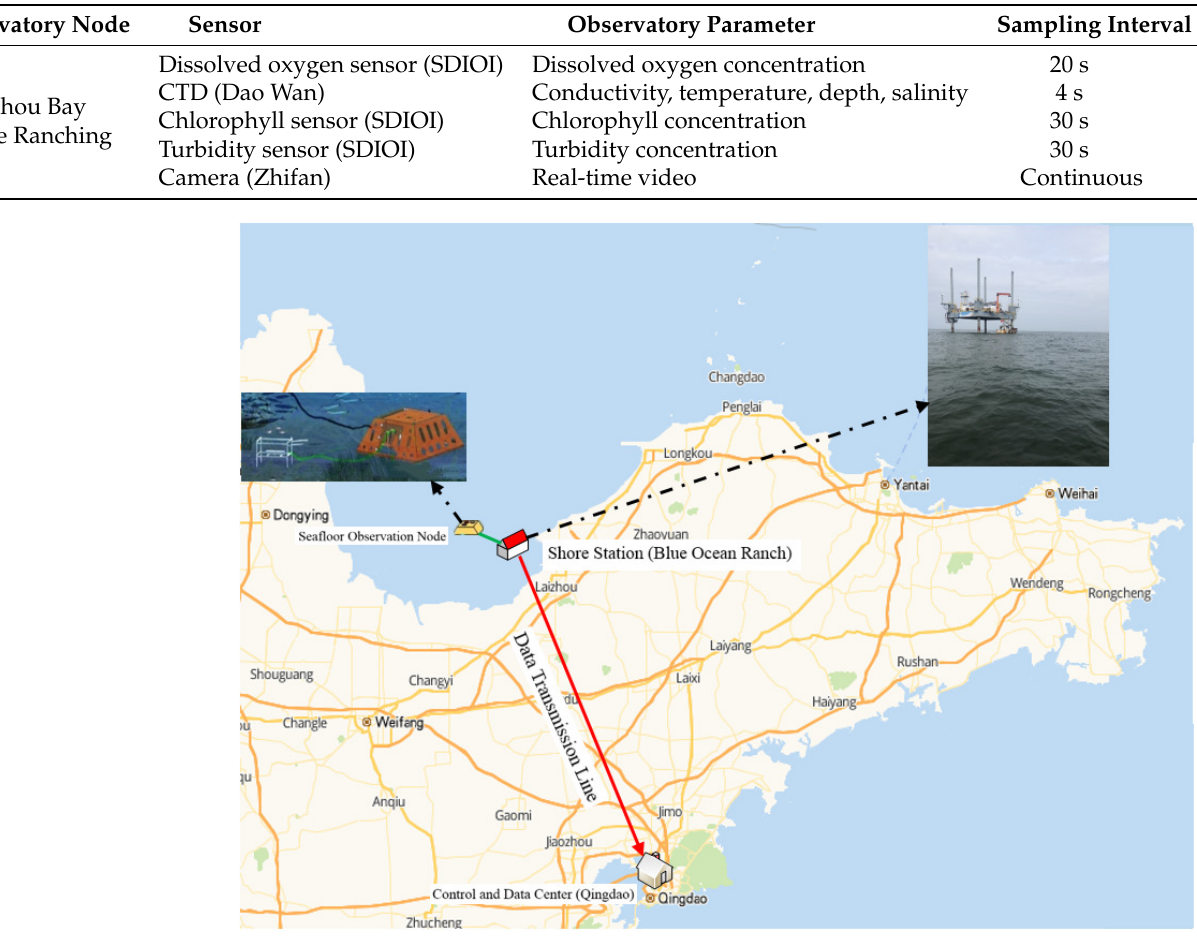
Figure 9. The seafloor observatory network in Laizhou Bay marine